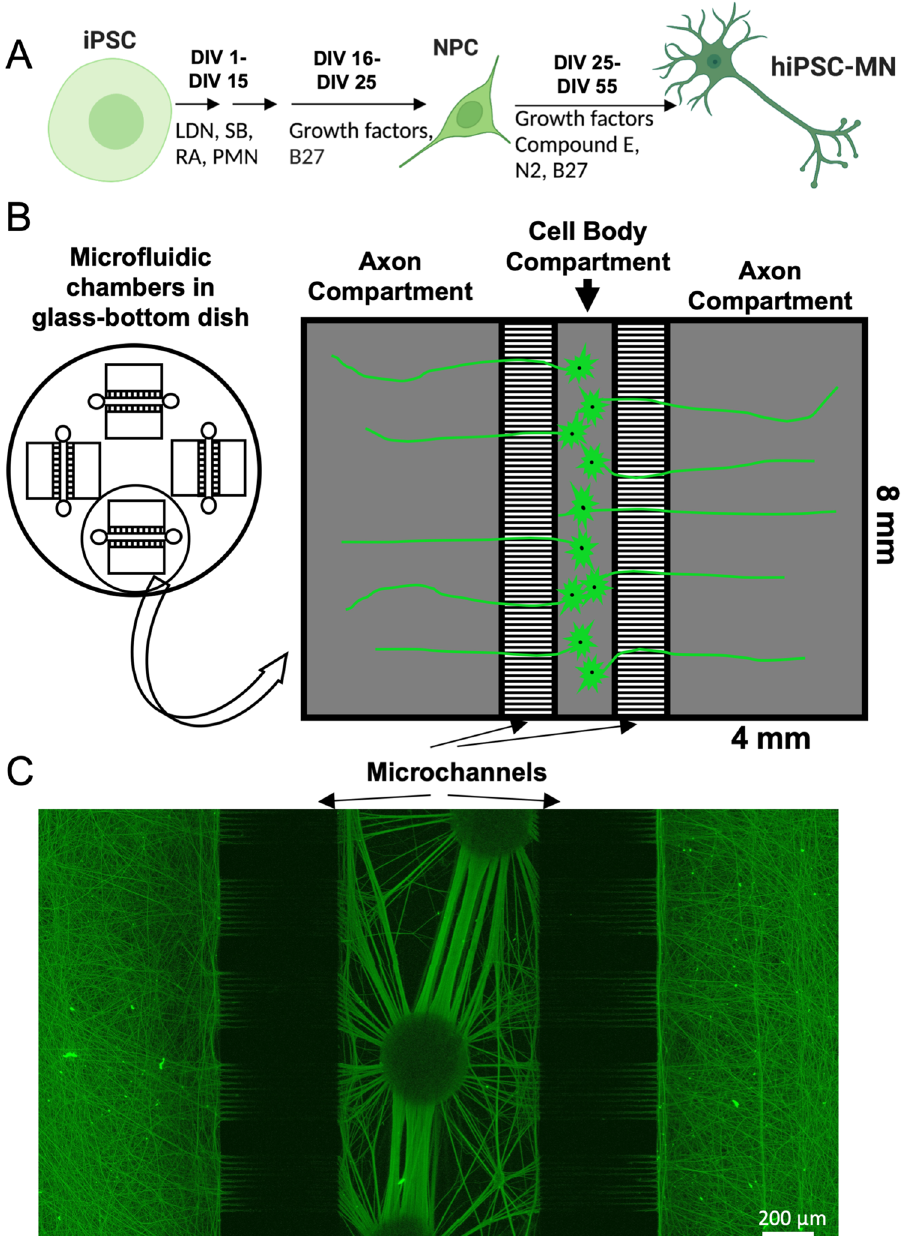
Figure 1. Compartmentalized culture system for investigating axonal outgrowth and regeneration of hiPSC- MNs. ( A ) Schematic representation of iPSC differentiation into spinal hiPSC-MNs. Created with BioRender. com (Supplementary information). ( B ) Compartmentalized microfluidic device for investigating regeneration of healthy control hiPSC-MNs. hiPSC-MN cell bodies are sequestered by microchannels into a central cell body compartment, and axons grow through microchannels into either axonal compartment. ( C ) hiPSC-MNs cultured in microfluidic device stained for smi-31 showing robust outgrowth into both axonal compartments. Scale bar = 200